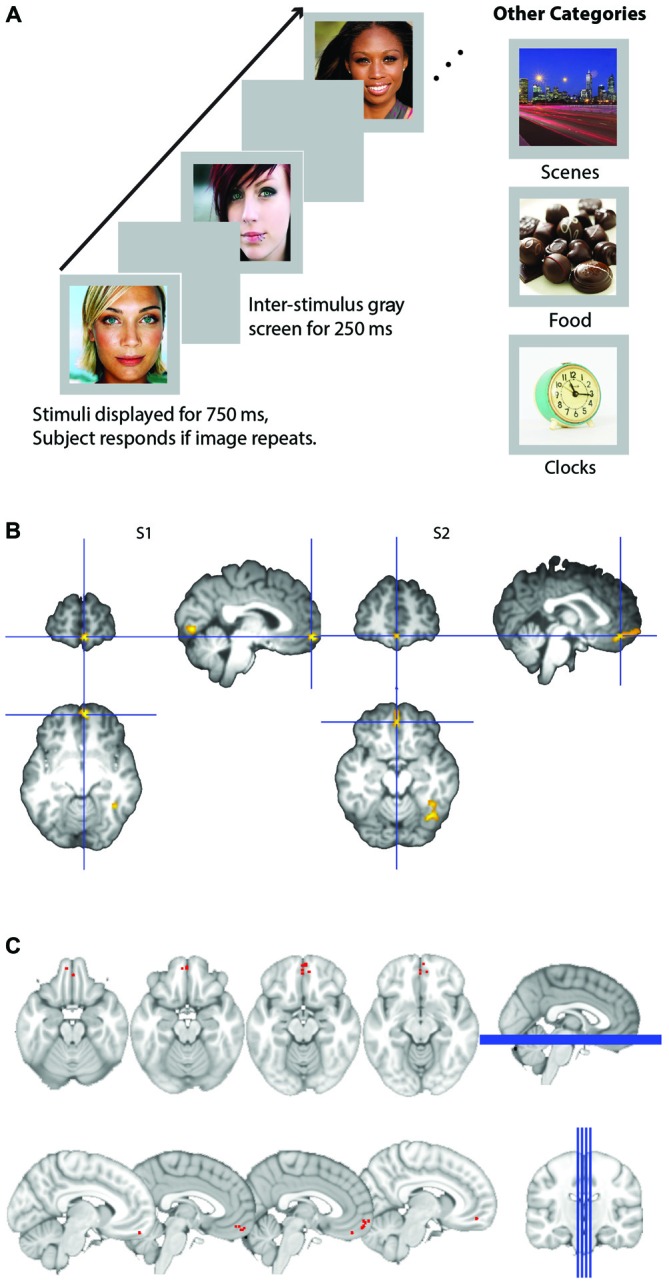
(A) Schematic of experimental design. Participants viewed images presented for 750 ms within a block and detected images that were consecutive repeats. Images were either male or female attractive and/or famous faces, scenes, appetizing food images, or clocks. (B) Representative subjects’ orbitofrontal cortex (OFC) face patch. Activation in medial OFC (mOFC) for the contrast of face stimuli compared to all other objects for two representative subjects. Contrast map is projected onto each subject’s high resolution T1, after skull extraction. OFC patches are located at the intersection of the blue crosshairs. (C) Plot of loci of all 14 subjects medial face patches. Loci are depicted as the coordinates of each subject’s peak voxel that responded more to faces than any other stimulus in the mOFC.